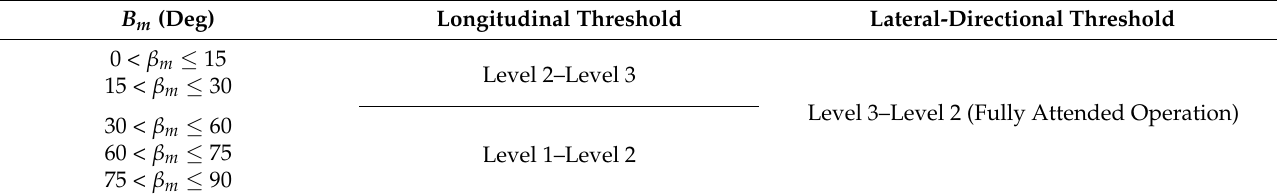
Table 3. Bandwidth and phase delay thresholds for uncertainty quantification.